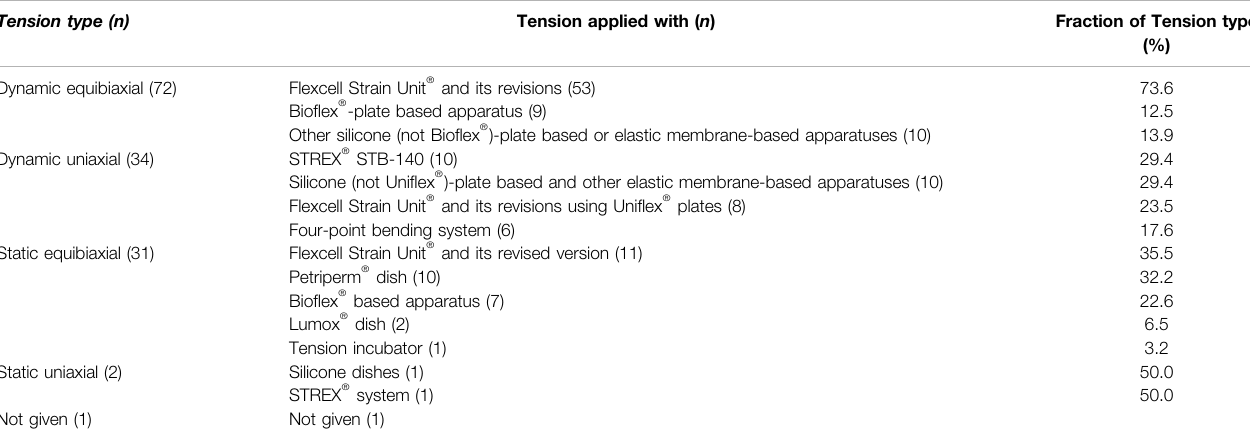
Dynamic equibiaxial